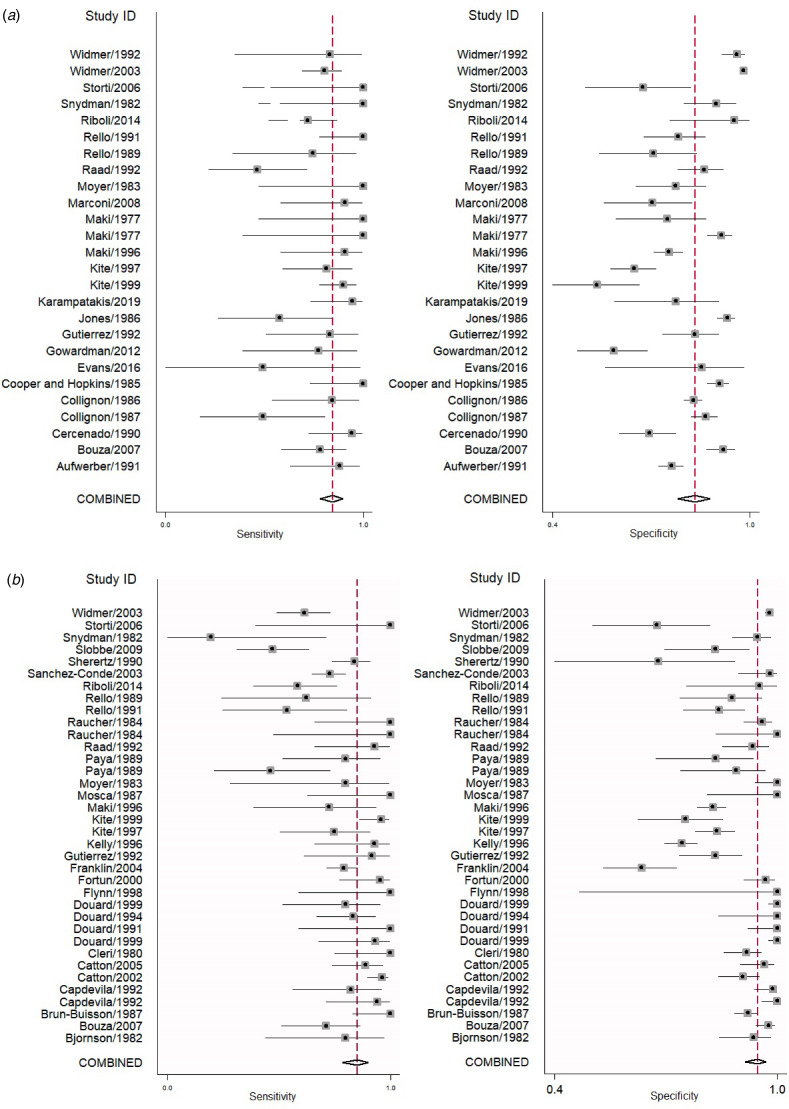
Forest plot showing pooled sensitivities and specificities. (a) For semi-quantitative methods, (b) for quantitative methods.